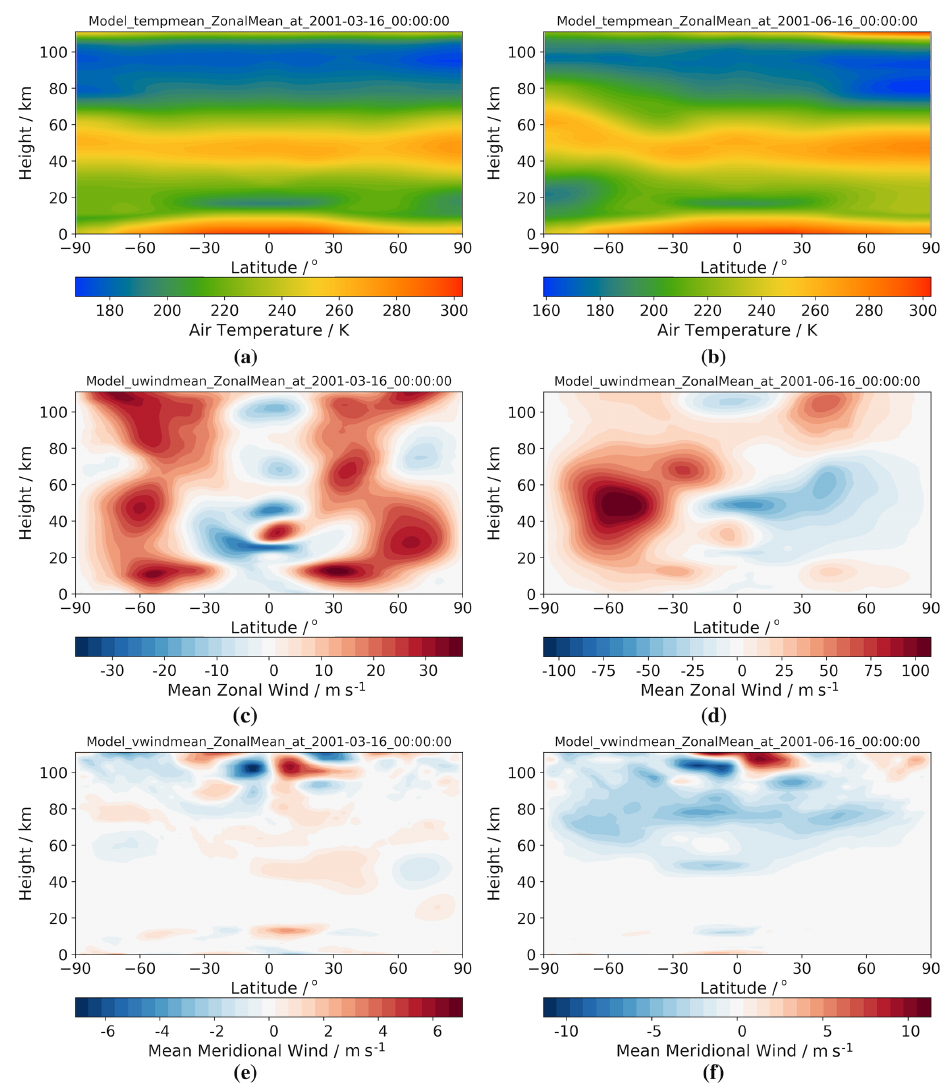
Figure 6. Latitude–height plot showing zonal and monthly mean fields for equinox (March) conditions for (a) temperature, (c) zonal ( u ) winds, and (e) meridional ( v ) winds and for solstice (June) conditions also for (b) temperature, (d) zonal ( u ) winds, and (f) meridional ( v )